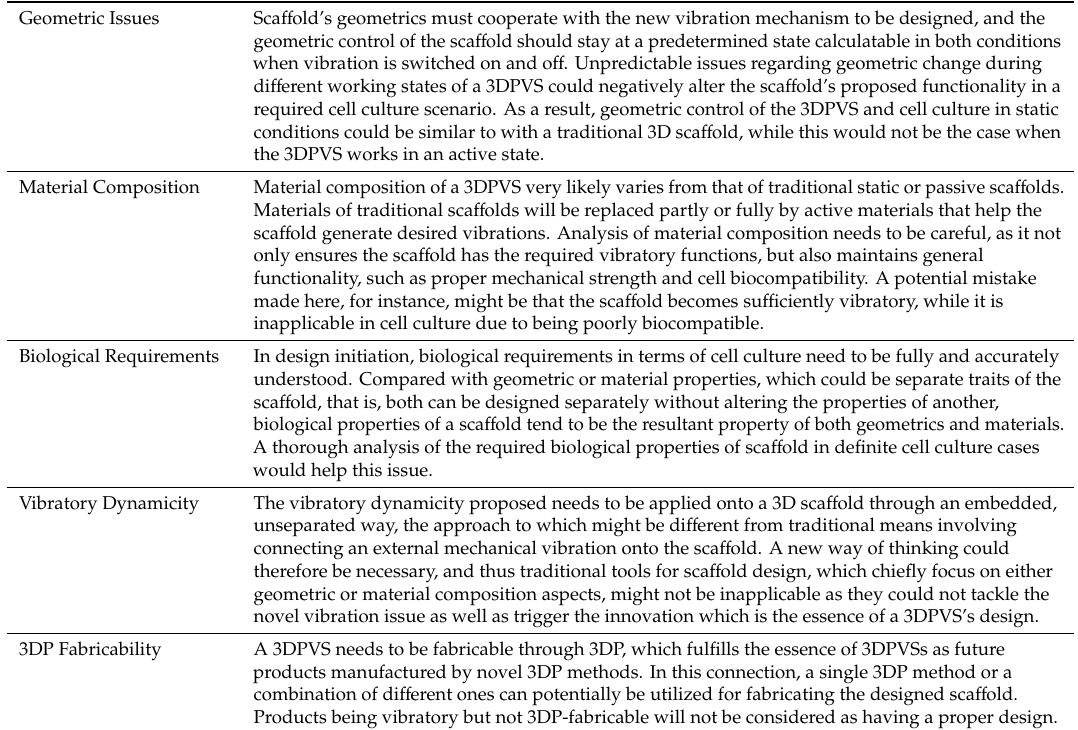
Table 1. Five perspectives focused upon by current design